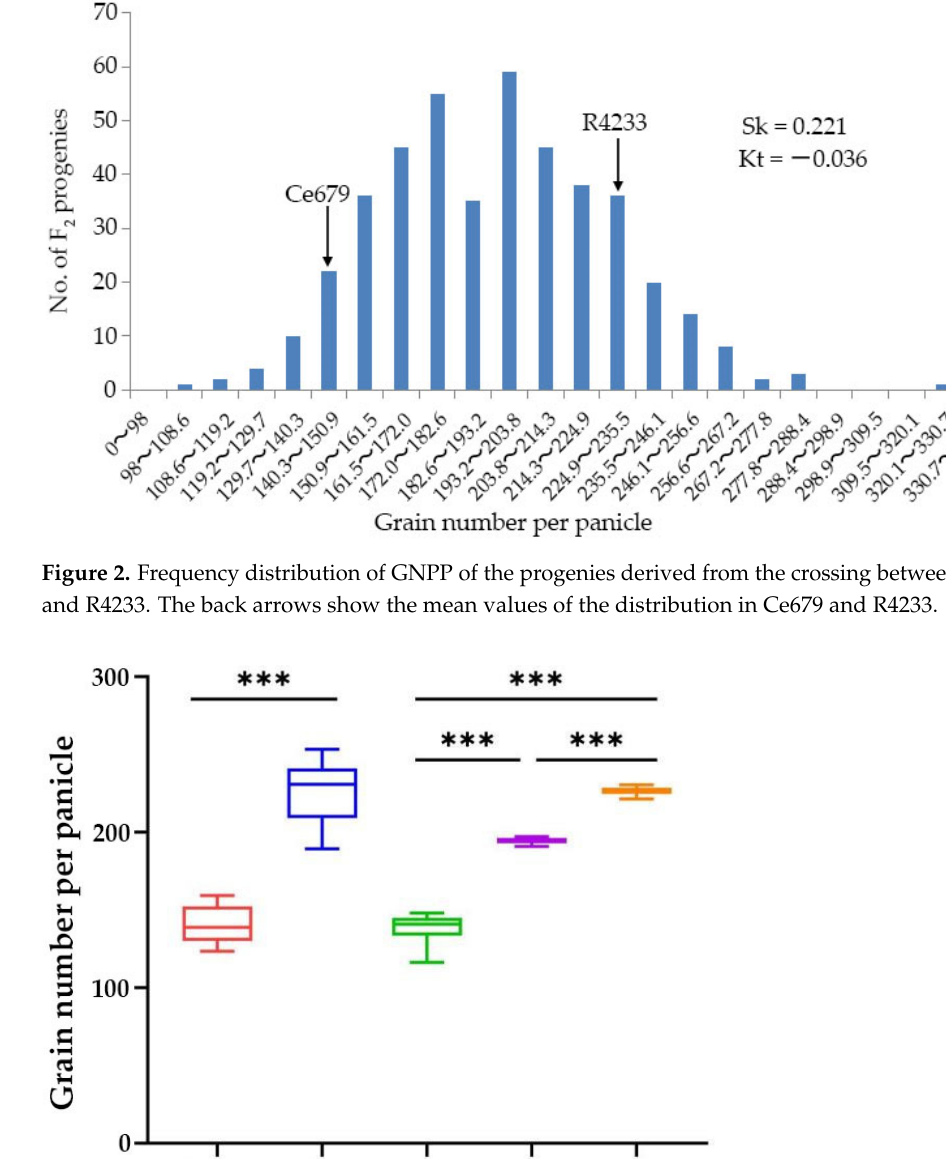
Figure 3. Box plots representing GNPP of the three BSA pools and parents. L-pool, M-pool, and H- pool show low, middle, high GNPP extremities, respectively, with the median indicated by the band inside the box. *** indicates p ≤ 0.001.